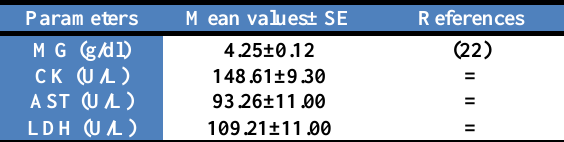
Table, 1: The normal mean values ± SE of MG, CK, AST, and LDH of the serum.